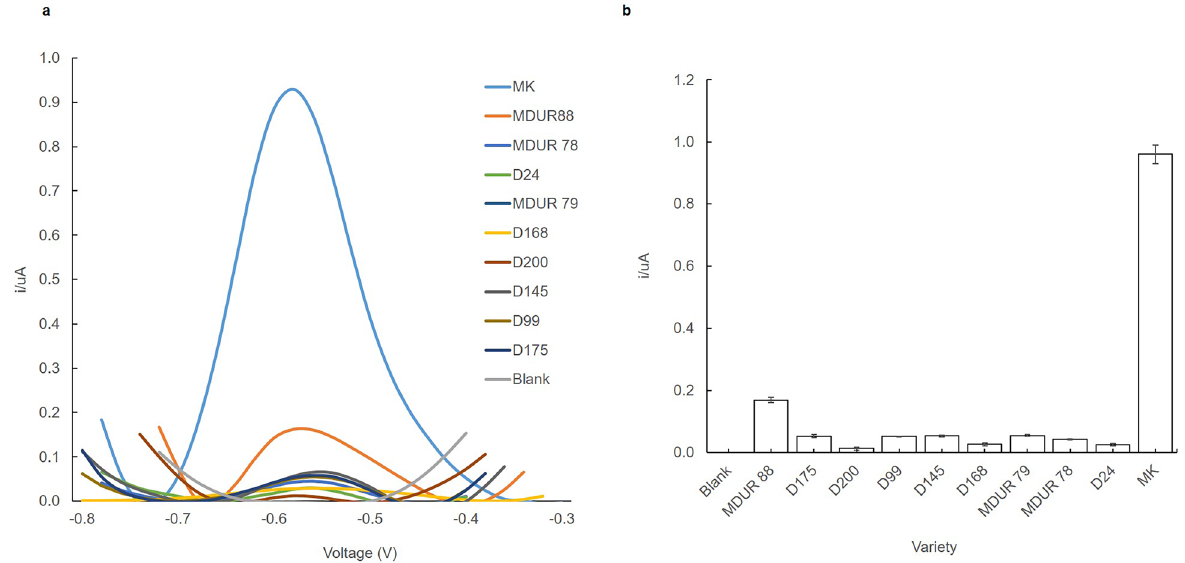
Figure 3. The durian varieties DNA biosensor response ( a ) and the biosensor response trends ( b ) after hybridization with different durian varieties of complementary DNA: (MK, D24, MDUR88, MDUR78, MDUR79, D168, D200, D145, D99, D175) and blank. The error bars represented standard deviations across three repetitive